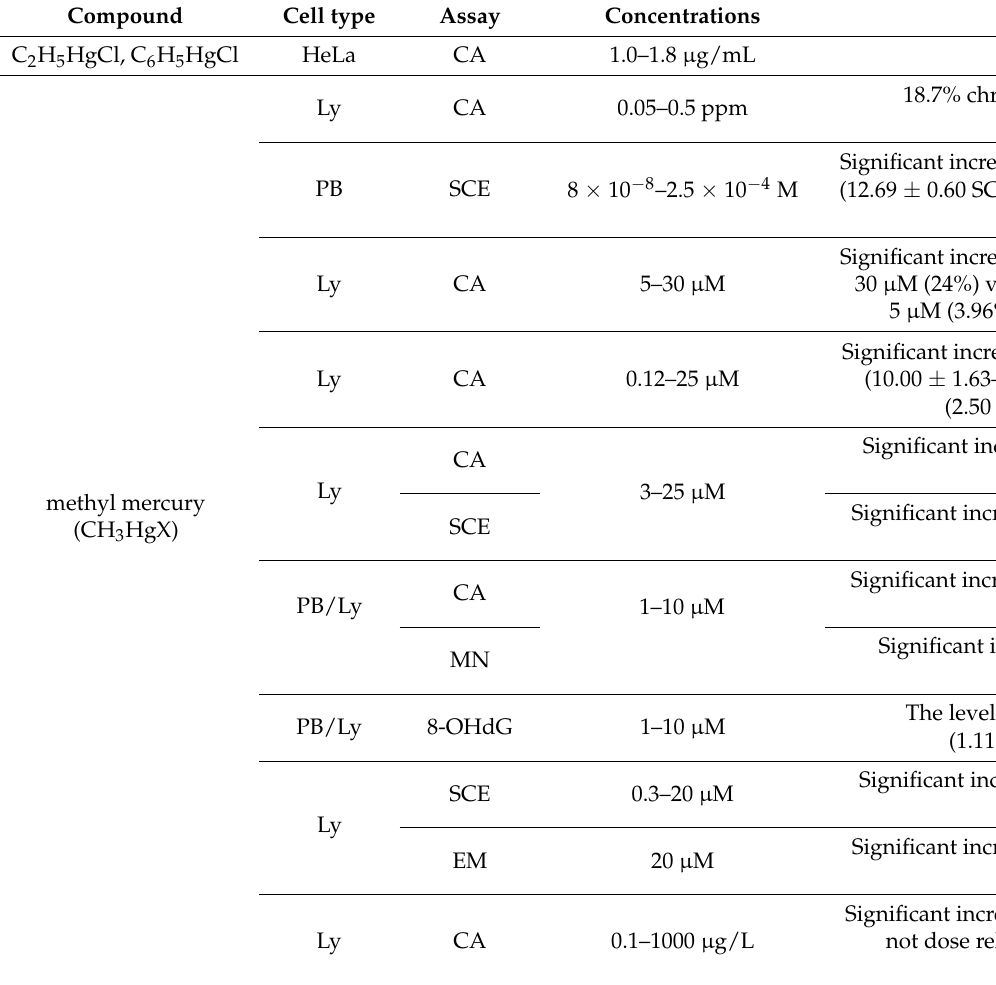
Table 2. Studies on in-vitro genotoxic effects by organic Hg